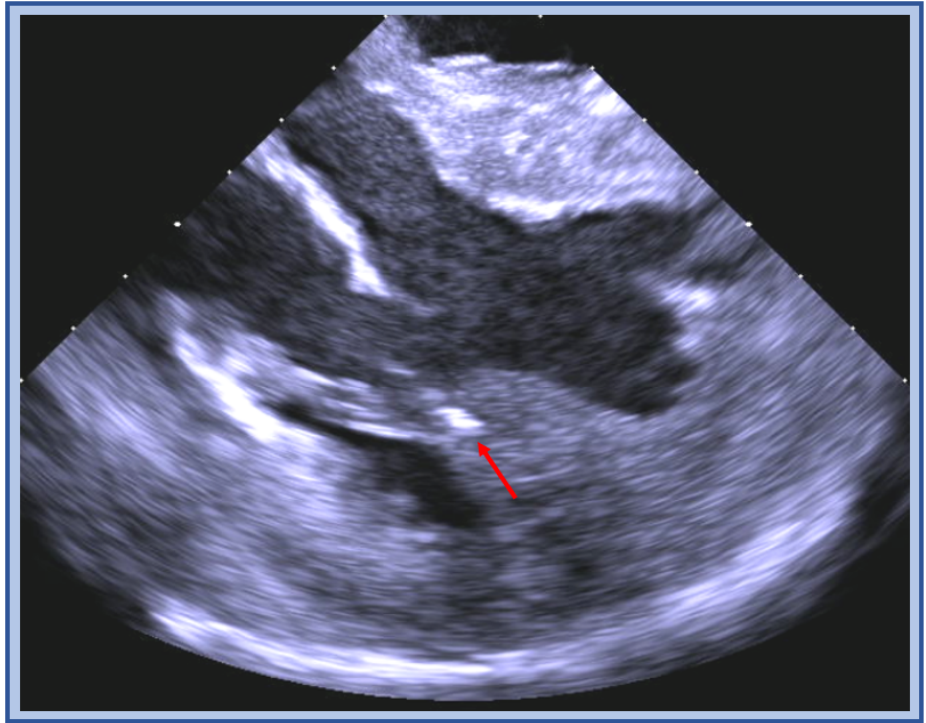
Figure 14. ICE image of cryoablation catheter positioned in between the two heads of the papillary muscle (red arrow) during ablation for added stability.